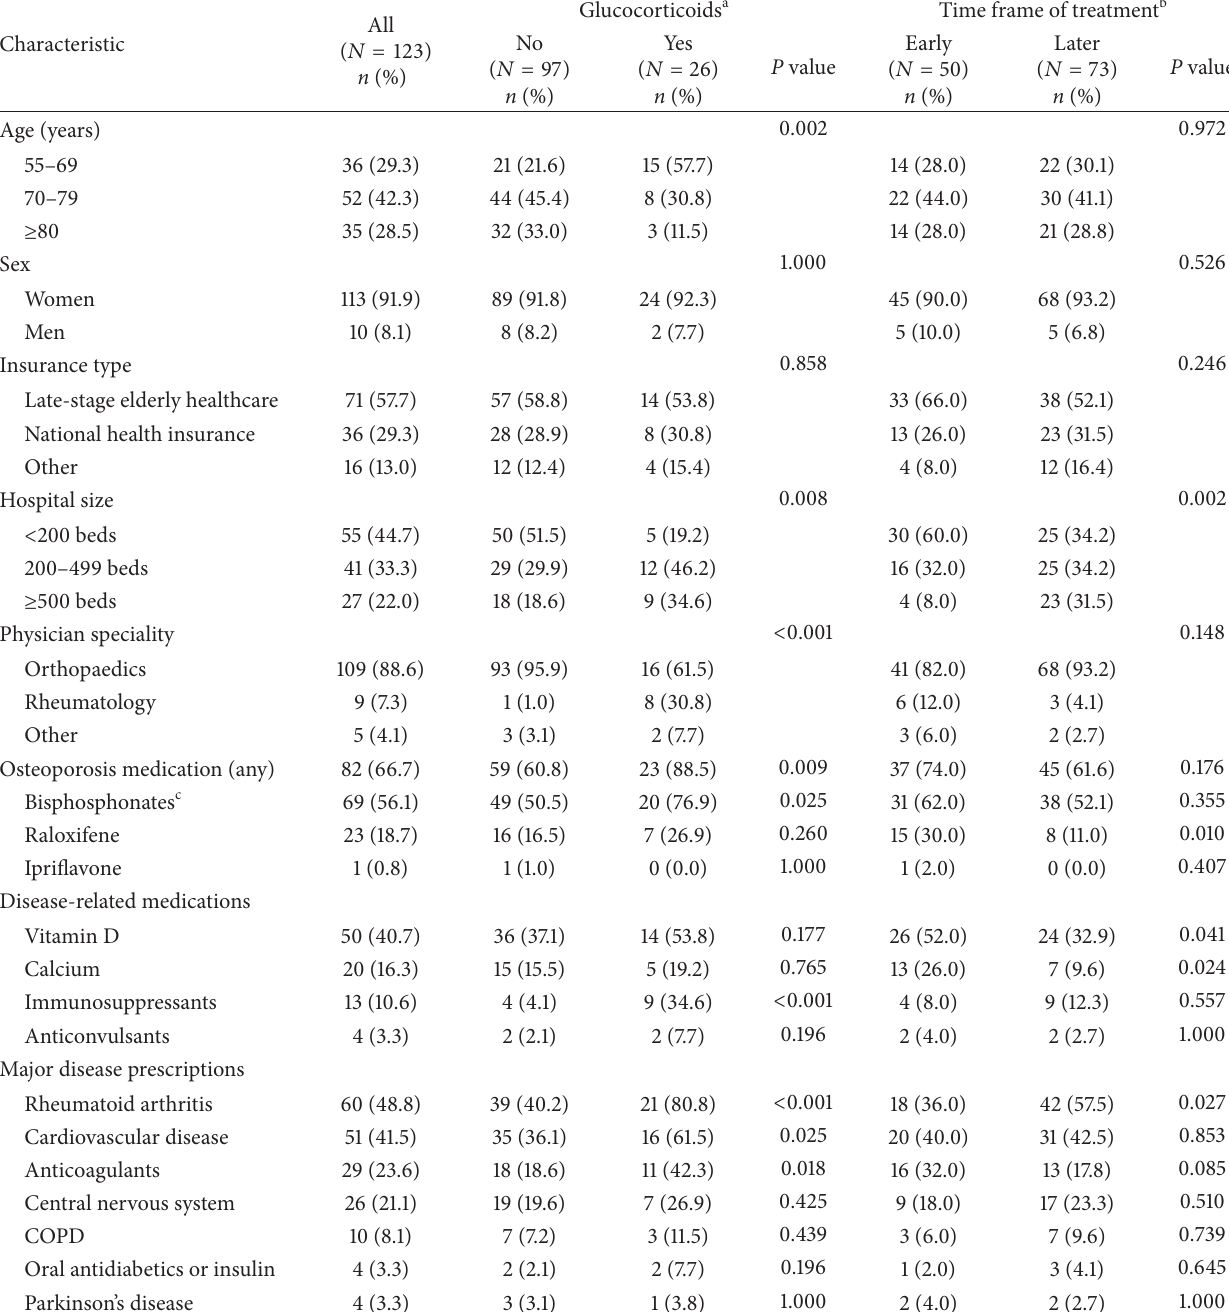
Table 1: Characteristics of patients who had prescriptions for once-daily teriparatide: overall, by glucocorticoid prescription, and by time